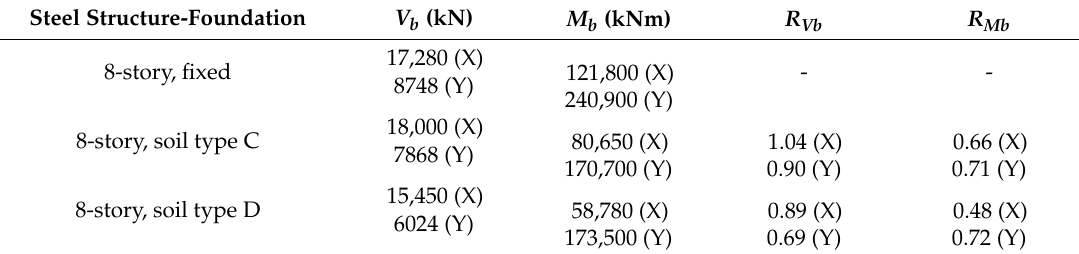
Table 13. Maximum V b , M b , and R values of the 8-story steel structure-foundation systems. Steel